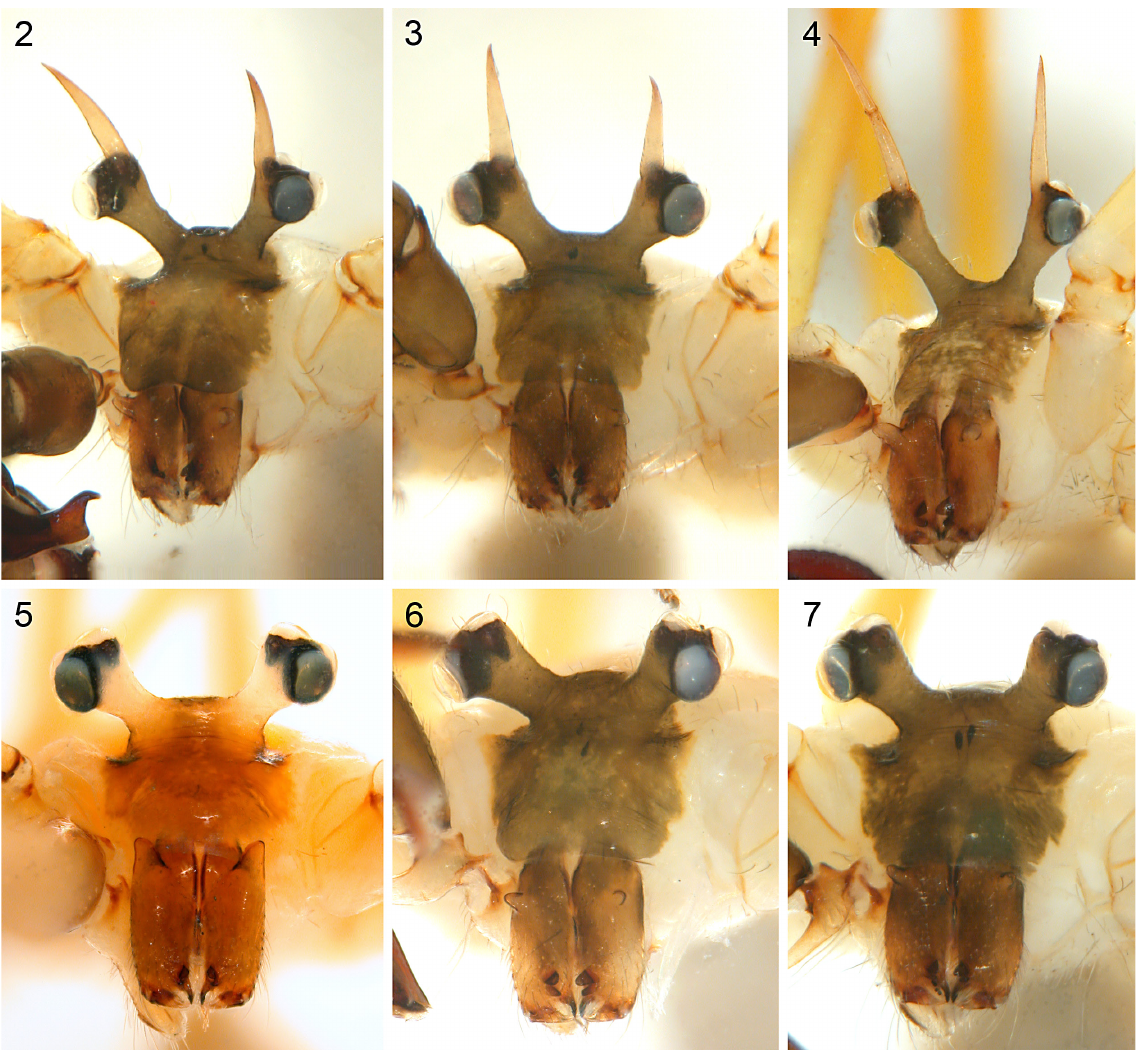
Figs 2–7. Male prosomata, oblique frontal views. 2 . Panjange pueh Huber, sp. nov. (ZFMK Ar 14576). 3 . Pa. niah Huber, sp. nov. (ZFMK Ar 14579). 4 . Pa. kapit Huber, sp. nov. (ZFMK Ar 14583). 5 . Pa. nigrifrons Deeleman-Reinhold & Deeleman, 1983 (RMNH, Sepaku). 6 . Pa. kubah Huber, sp. nov. (ZFMK Ar 14587). 7 . Pa. seowi Huber, sp. nov. (ZFMK Ar